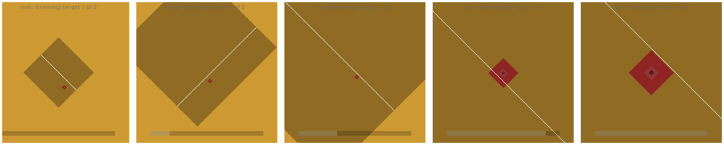
The visual display used in the experiment.A single target is shown in red, appearing at an initial random location. The target has sides of length 2−6. A diagonal split is used to elicit user responses and linear zooming is used. A progress bar shows the entropy drop remaining.